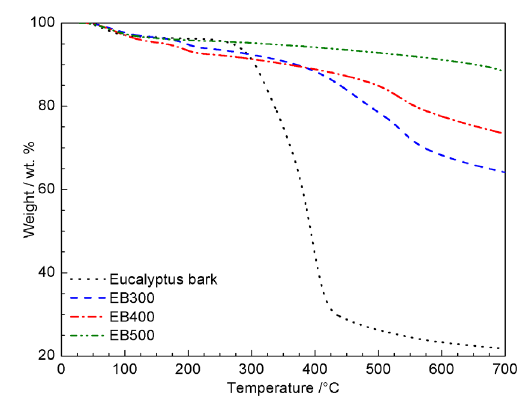
Figure 2. TG curves for eucalyptus bark and charcoal produced in nitrogen atmosphere and heating rate of 20 °C.min -1 .